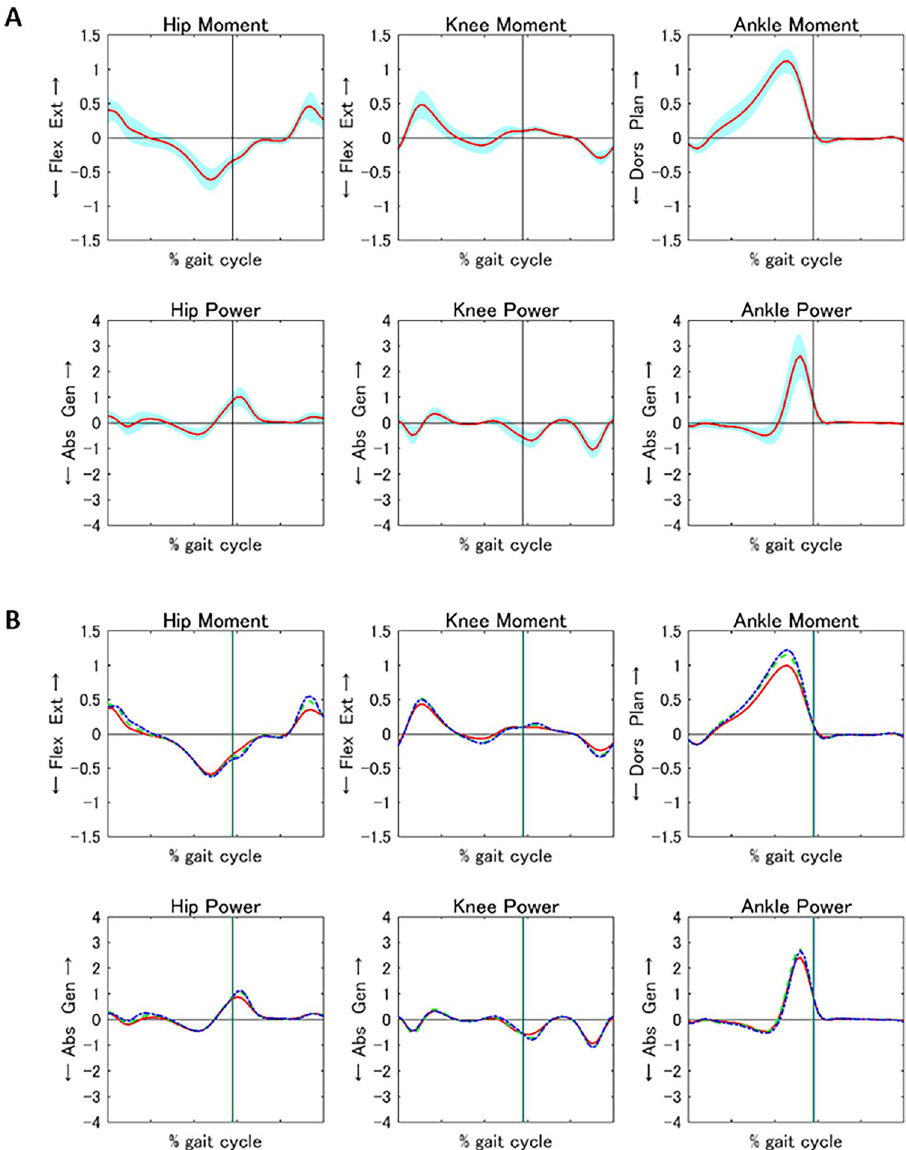
Figure 2. Mean kinetic curve generated using the values of the gait standards in the total population and three subgroups: hip flexion/extension, hip knee flexion/extension, ankle dorsiflexion/plantarflexion, hip power, knee power, and ankle power . ( a ) Mean kinetic curve (red line) with the standard deviation (blue area) in the whole population. ( b ) Mean kinetic curves in the three age groups, including Groups A (6–8 years, red line), B (9–10 years, green dotted line), and C (11–12 years, blue dotted line). Abs, absorption; Dors, dorsiflexion; Ext, extension; Flex, flexion; Gen, generation; Plan,